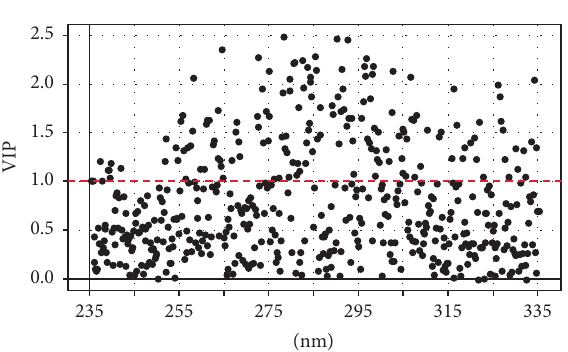
Figure 4: Variable Importance for the Projection (VIP) plot of absorbance for the contribution to sample separation from